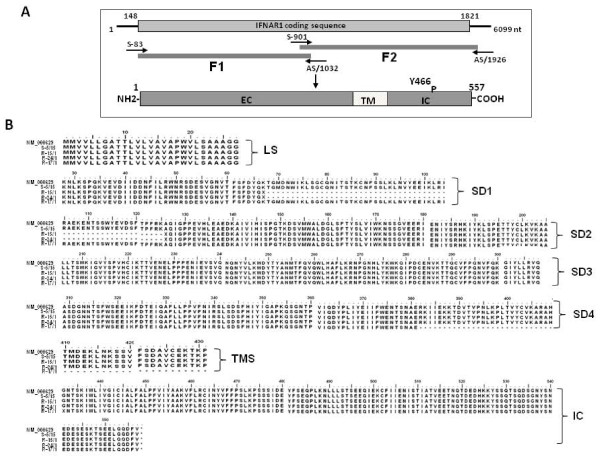
Schematic diagram and sequence analysis of open reading frame of human IFNAR1 by RT-PCR from the S-5/15 and R-15/1, R-17/1 and R-24/1 cells. (A) Location of sense and antisense primers used for RT-PCR analysis of IFNAR1 coding sequence. The human IFNAR1 protein is 557 amino acids long that consist of an N-terminal extracellular cytokine-binding (EC) domain (436 aa), a hydrophobic transmembrane (TM) domain (21 aa), and C-terminal intracytoplasmic (IC) domain (100 aa). F1 and F2 are the two PCR fragments amplified for final overlapping PCR of full-length IFNAR1. (B) The amino acid sequence of IFNAR1 of S-5/15 cells perfectly matches with the reference wild type sequence of IFNAR1 m RNA (Accession no- NM_000629). The R-15 and R-24 series resistant Huh-7 clone show an N-terminal deletion of 58 amino acids starting from 68 aa to 125 aa in the IFNAR1. The R-17 series resistant Huh-7 cell clones show deletion of 50 amino acids staring from 382aa to 431 aa in the SD4 domain of IFNAR1. The dotted line indicates the deletion portion in the sequence.